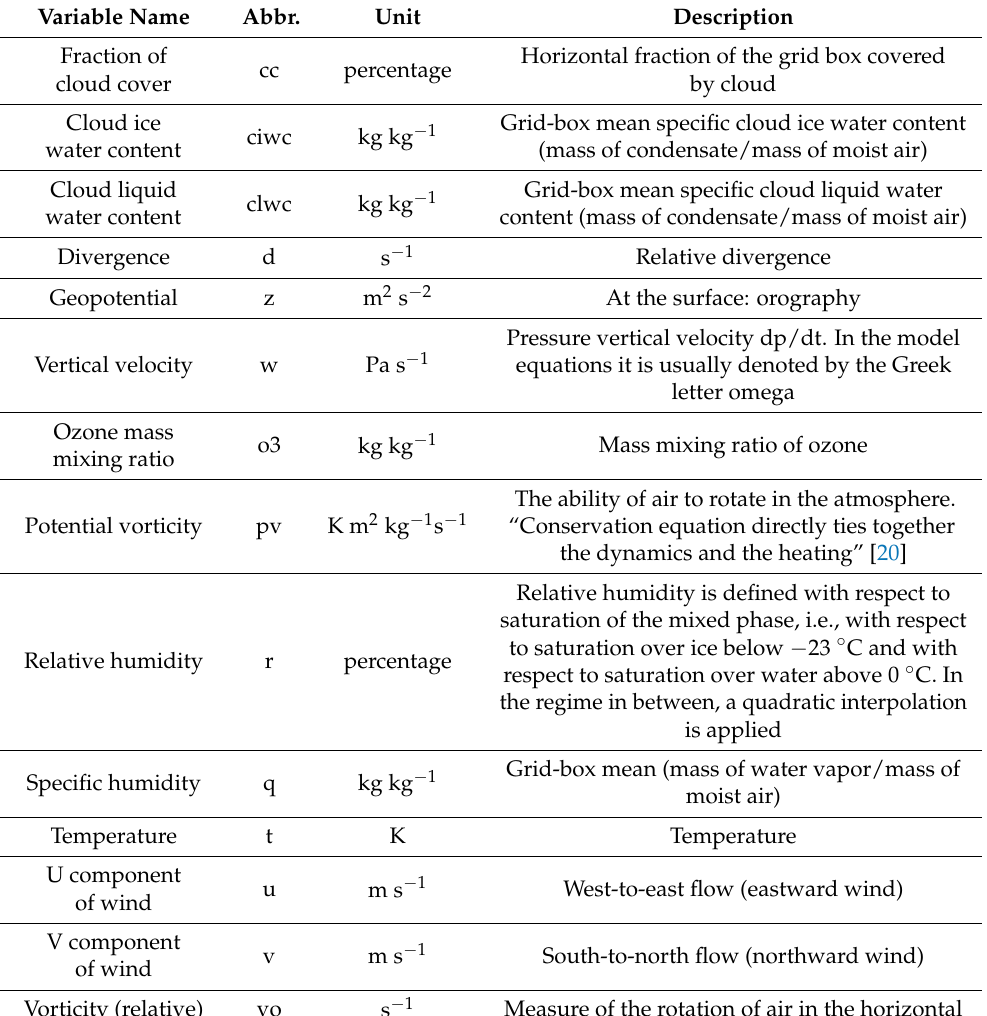
Table 1. Variable names, abbreviations (abbr.), units, and description for the 14 variables in the ERA-Interim pressure level